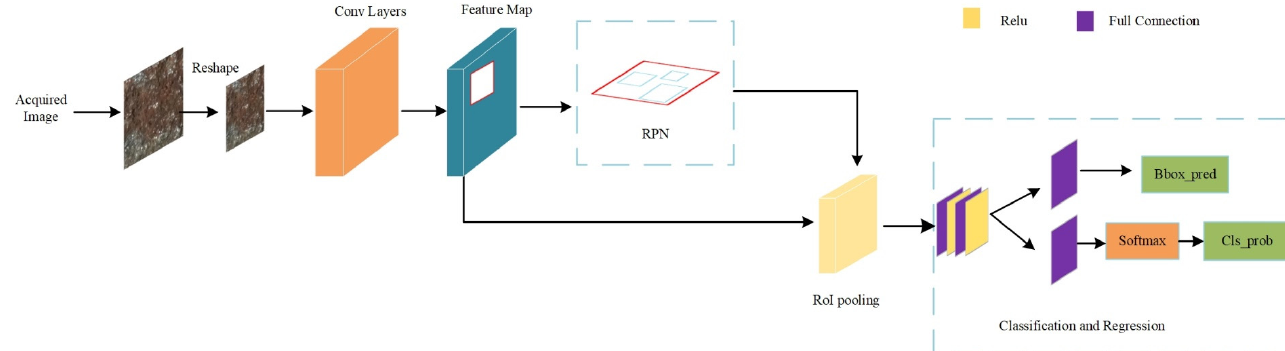
Figure 1. FR-CNN model structure.